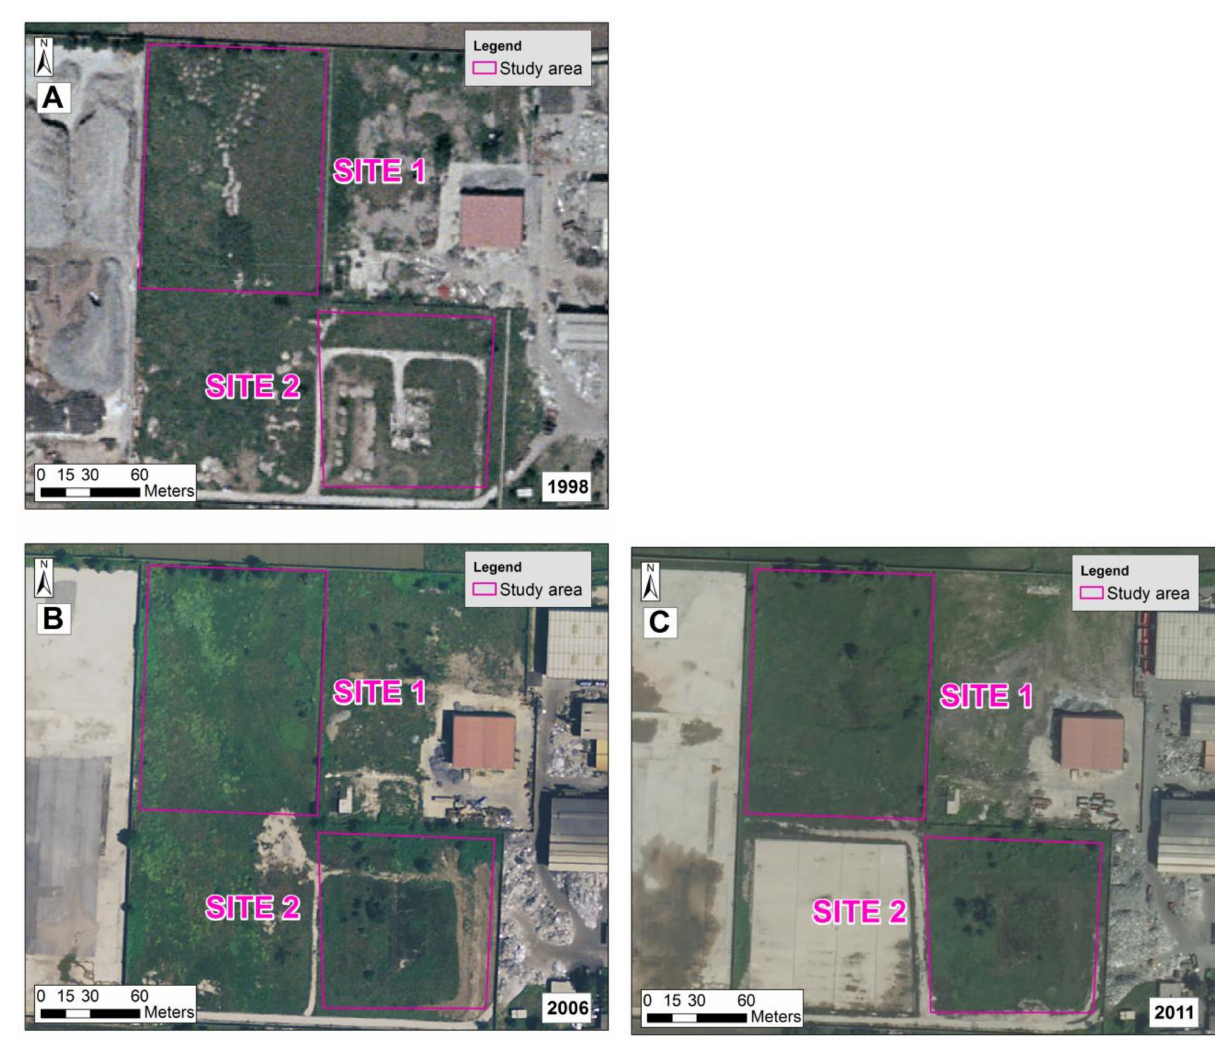
Figure 3. Archive pictures of the site in 1998 ( A ), 2006 ( B ) and 2011 ( C ).